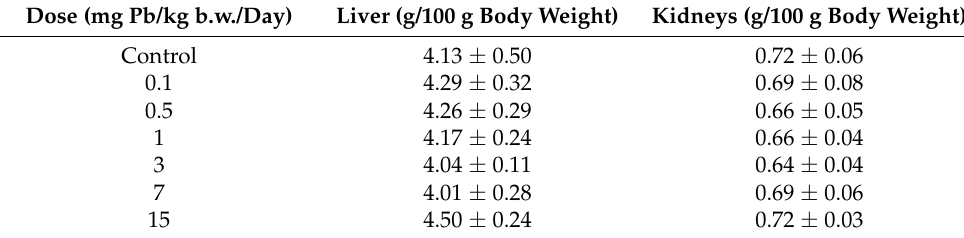
Table 1. Relative organ weight of rats subacutely treated with different low Pb doses. Dose (mg Pb/kg b.w./Day)